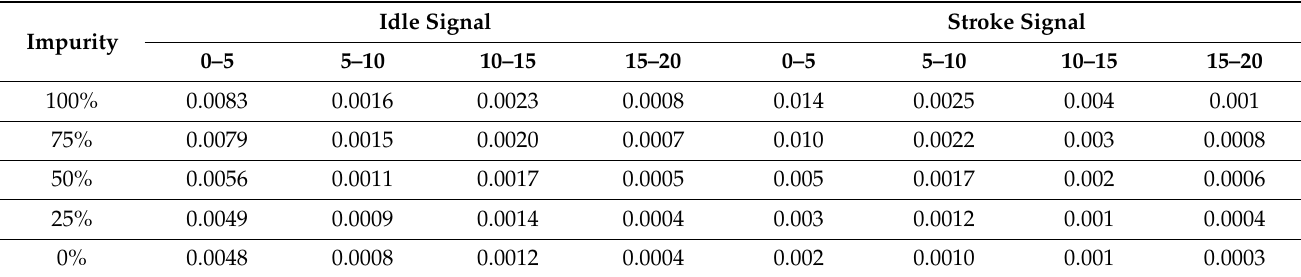
Table 1. Highest frequency amplitudes between 5 kHz steps of X -axis.